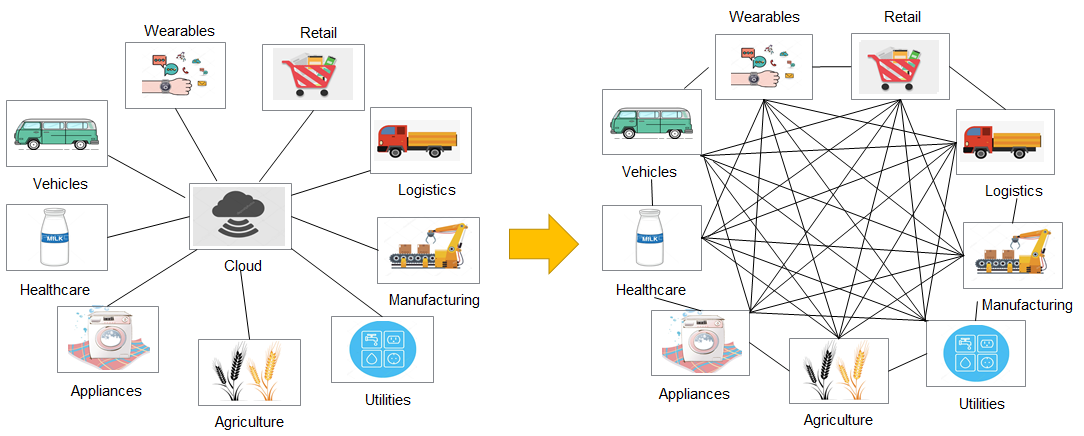
Figure 1. Decentralization of management using